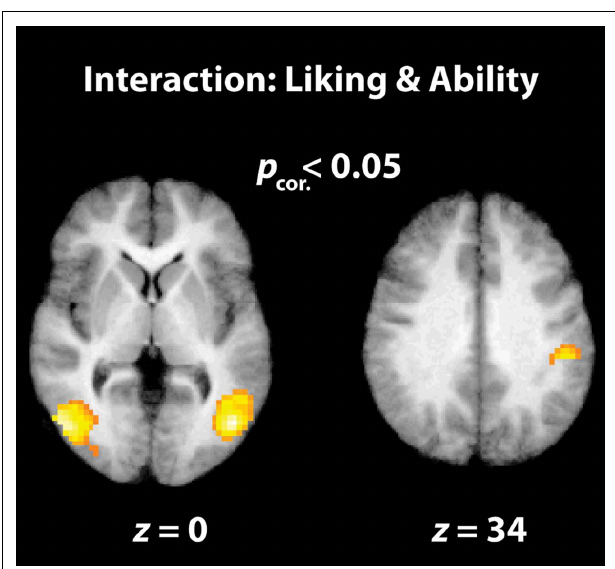
FIGURE 3 | “Increased liking” and “decreased physical ability” parameters. (A) Illustrates the three cluster-corrected activations that demonstrate increasing BOLD signal strength the more participants like the dance movement. (B) Illustrates the conjunction between regions with greater responses the more difficult participants think a